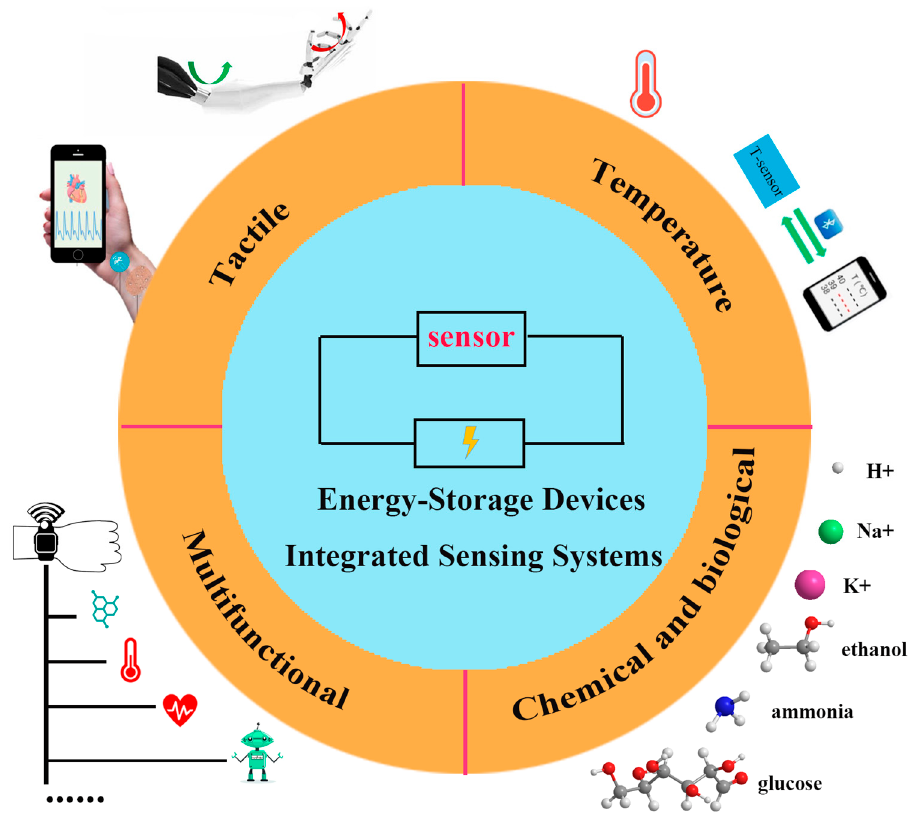
Figure 1. Schematic diagram of Energy-storage-device-integrated Sensing Systems. Reprinted with permission from Ref. [33]. Copyright 2021, Advanced Materials. Reprinted with permission from Ref. [34]. Copyright 2020, Science Robotics. Reprinted with permission from Ref. [35]. Copyright 2020, Biosensors and Electronics.